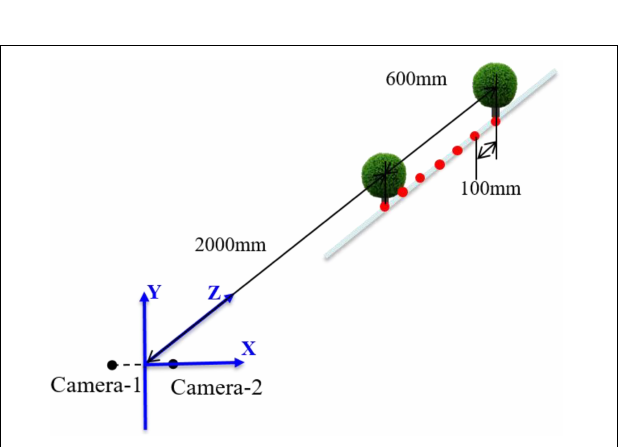
FIGURE 16 | Comparison of before and after stereo correction.